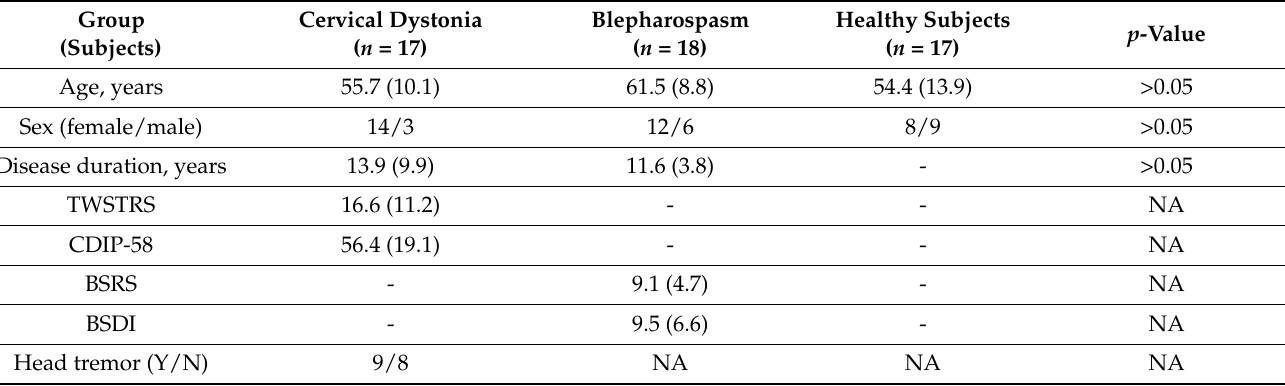
Table 1. Demographic and clinical characteristics of patients and healthy